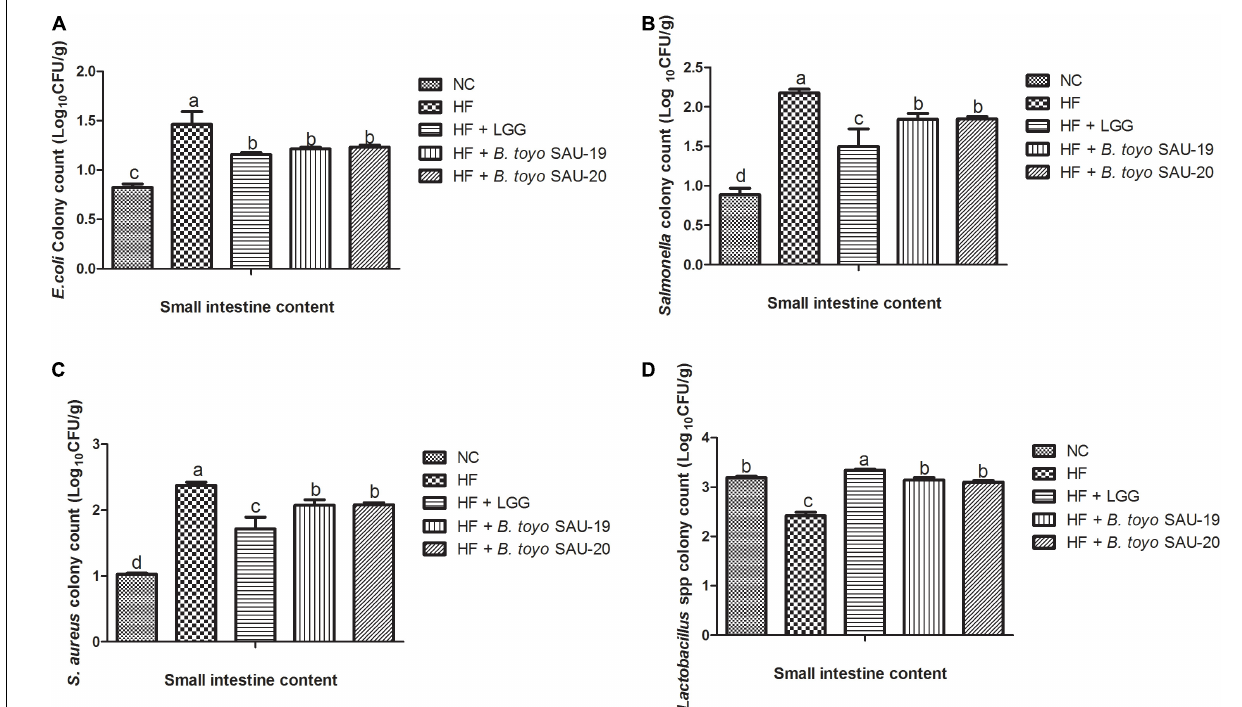
FIGURE 7 | Effects of Bacillus toyonensis SAU-19 and SAU-20 on bacteria enumeration in small intestine contents of mice fed high fat diet (A) colony count of Escherichia coli, (B) colony count of Salmonella spp., (C) colony count of Staphylococcus aureus, (D) colony count of Lactobacillus spp. The values are presented as the mean ± SD. Bars without the same letter differed significantly ( n = 6, P < 0.05) the same. NC, mice were administered normal diet + normal saline; HF, mice were fed high fat diet + normal saline; HF + LGG, mice were administered high fat diet + 10 6 Lactobacillus rhamnosus GG; HF + B. toyo. SAU-19, mice were administered high fat diet + 10 6 Bacillus toyonensis SAU-19 from A. adenophora ; HF + B. toyo. SAU-20, mice were administrated with high fat diet + 10 6 Bacillus toyonensis SAU-20 from A. adenophora